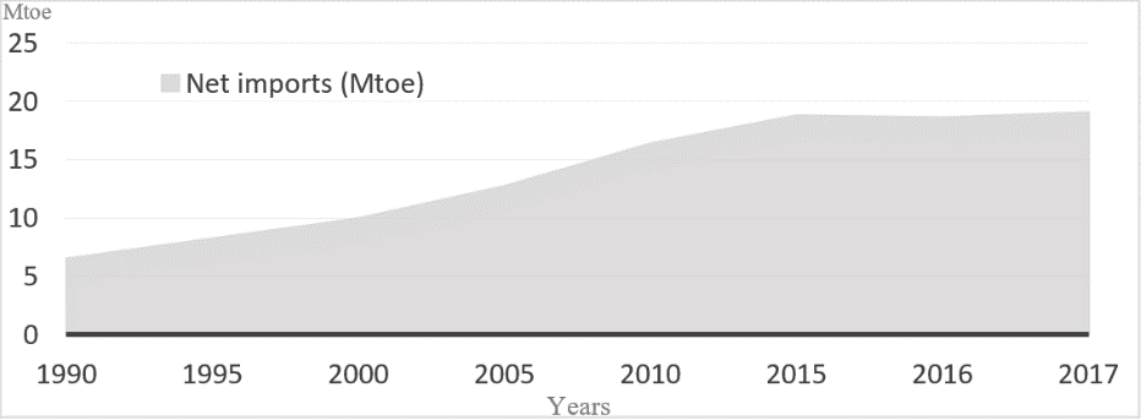
Energies 2022 , 15 , x FOR PEER REVIEW Figure 1. Net energy imports 1990 – 2018 (Mtoe) in Morocco [31]. Figure 1. Net energy imports 1990–2018 (Mtoe) in Morocco [31].